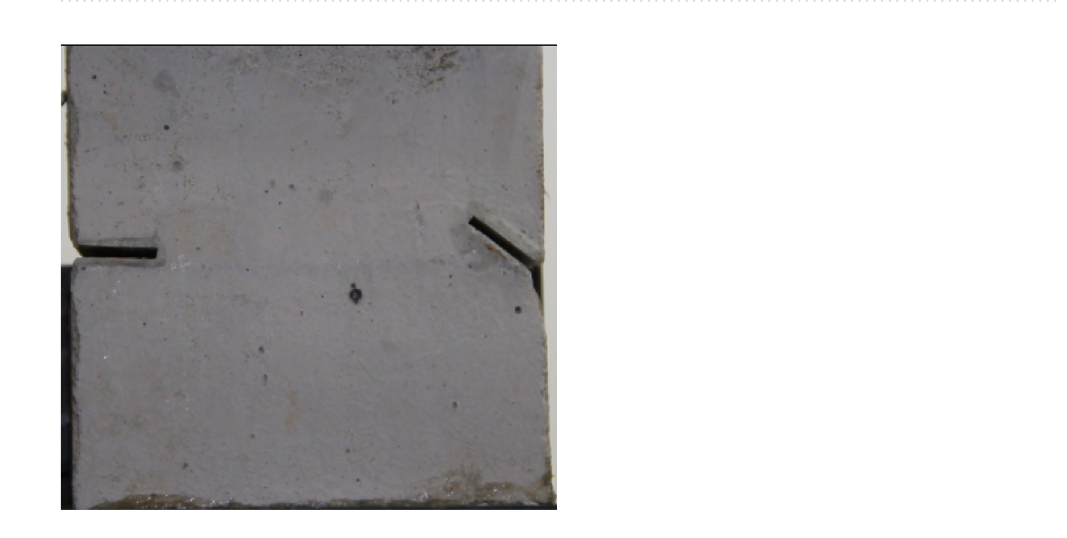
Figure 1. Mould for casting samples and six steel sheets used to form cracks in the samples.